Question: Write a single sentence explaining what this figure depicts.
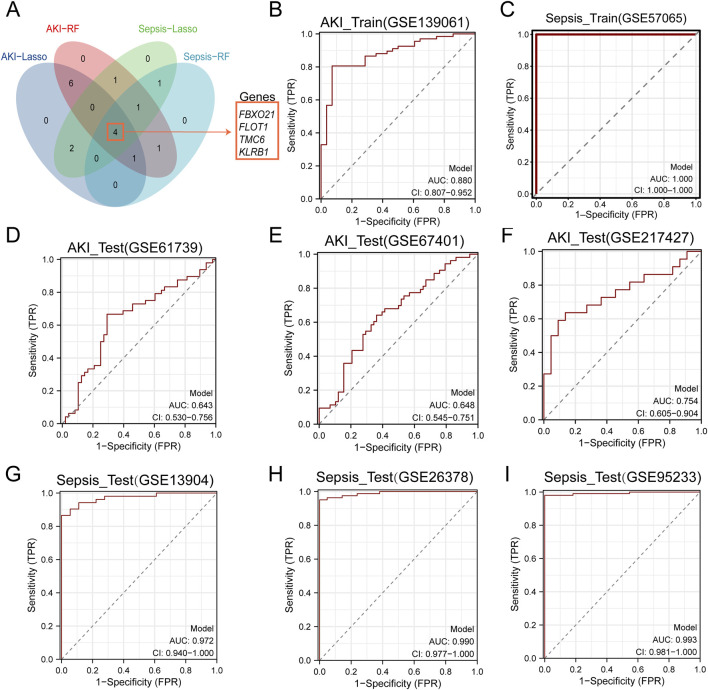
Answer: Identification of shared diagnostic genes and construction and validation of diagnostic models across multiple datasets. (A) Venn diagram displaying the intersection of feature genes selected by LASSO and RF algorithms within the AKI and sepsis datasets. (B–I) ROC curve analysis of the combined diagnostic gene model for predicting acute kidney injury and sepsis. (B) The AKI training set ( GSE139061 ). (C) The sepsis training set ( GSE57065 ). (D–F) Three independent AKI external validation cohorts: GSE61739 (D) , GSE67401 (E) , and GSE217427 (F) . (G–I) Three independent sepsis external validation cohorts: GSE13904 (G) , GSE26378 (H) , and GSE95233 (I) . The Area Under the Curve (AUC) and 95% Confidence Interval (CI) are annotated in the plots.